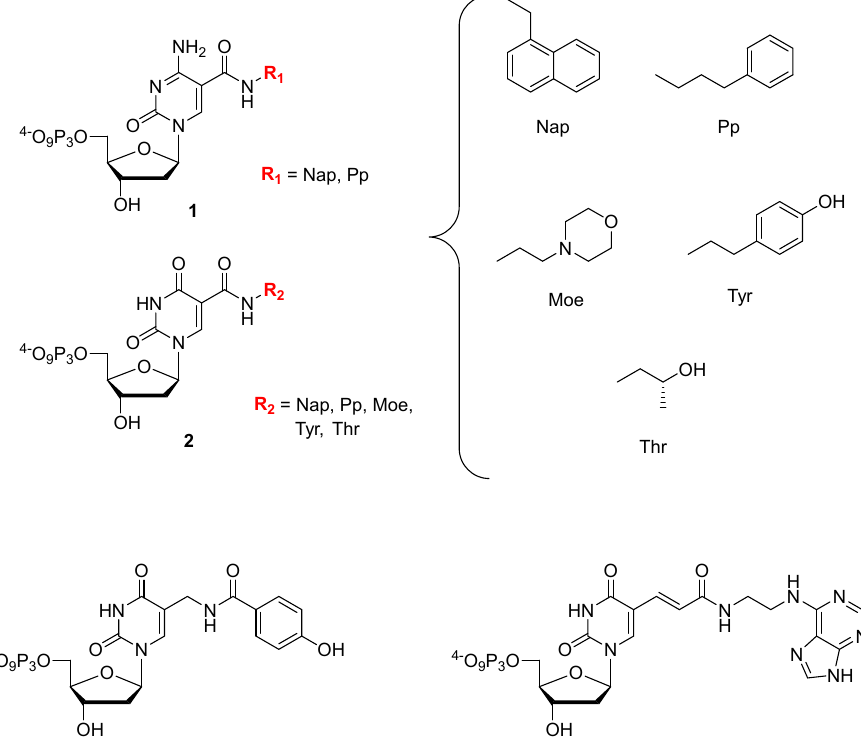
Figure 7. Chemical structures of base-modified nucleoside triphosphates used in selection experiments of aptamers with an expanded chemical repertoire.